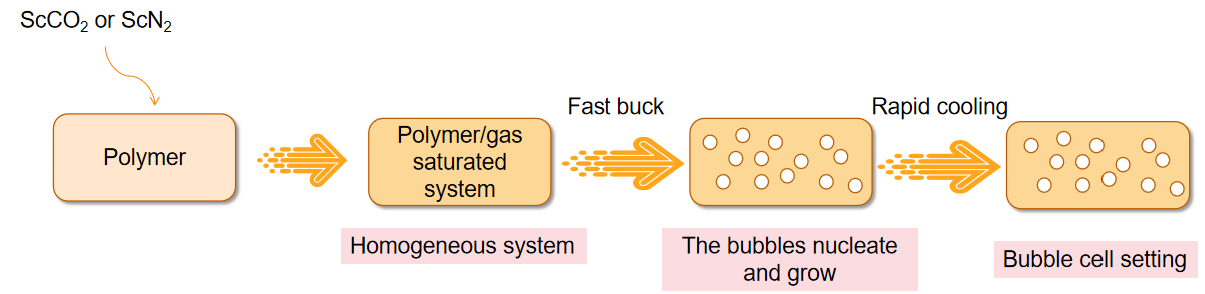
Figure 1. Flow chart of supercritical foaming technology.